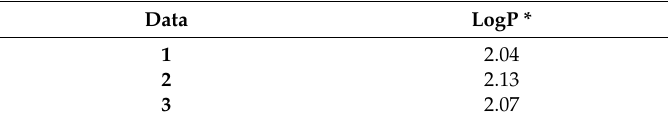
Table 3. Results of LogP from the triplicate experiments.